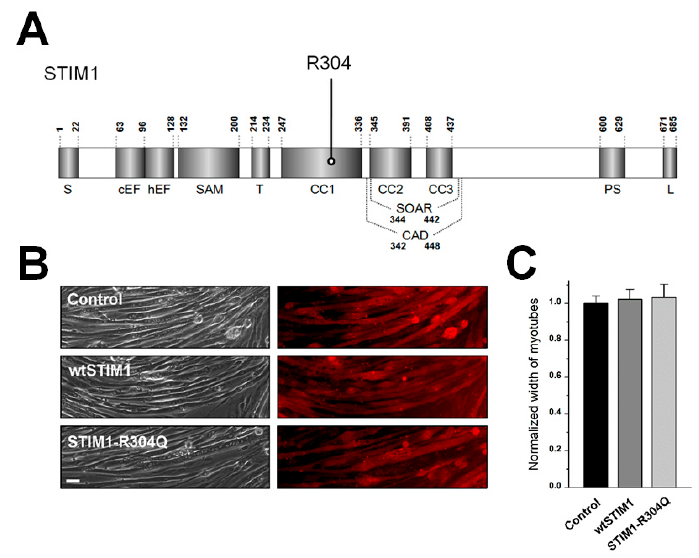
Figure 1. Schematic of the primary structure of STIM1, the expression of wtSTIM1 or STIM1-R304Q in mouse primary skeletal myotubes, and myotube width: ( A ) the location of R304 is indicated. Numbers indicate the amino acid sequence. Each domain of STIM1 is present [7]. S, signal peptide; cEF, canonical EF-hand; hEF, nonfunctional hidden EF-hand; SAM, sterile α -motif; T, transmembrane domain; CC, coiled-coil domain; CAD/SOAR, Ca 2+ release-activated Ca 2+ -activating domain/STIM1-Orai1-activating region; PS, proline/serine-rich domain; and L, lysine-rich domain; ( B ) mouse primary skeletal myotubes that were transfected with cDNA of empty vector (control), wtSTIM1, or STIM1-R304Q were stained with anti-GFP (for detecting CFP or CFP-tagged proteins) and Cy3-conjugated secondary antibodies. The bar represents 100 μ m; ( C ) myotube width was measured. The mean values of each normalized to the mean value of the control are summarized as histograms (Table 1). Table 1. Properties of wtSTIM1 or R340Q-expressing mouse primary skeletal myotubes. The values, except for those of the cytosolic Ca 2+ levels at rest, were normalized to the mean value of those from the control. The values are presented as the mean ± SE for the number of myotubes shown in parentheses. * Significant difference compared with control ( p < 0.05). # Significant difference compared with wtSTIM1 ( p < 0.05).